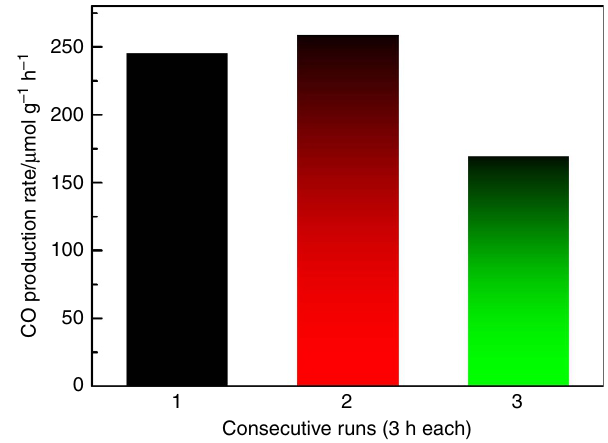
Figure 5 | Temperature effect. CO production rates of three ncSi:H film samples tested at different heating temperatures (130 (cid:2) C, 150 (cid:2) C, and 170 (cid:2) C), first in the dark (D) and then in the light (L).